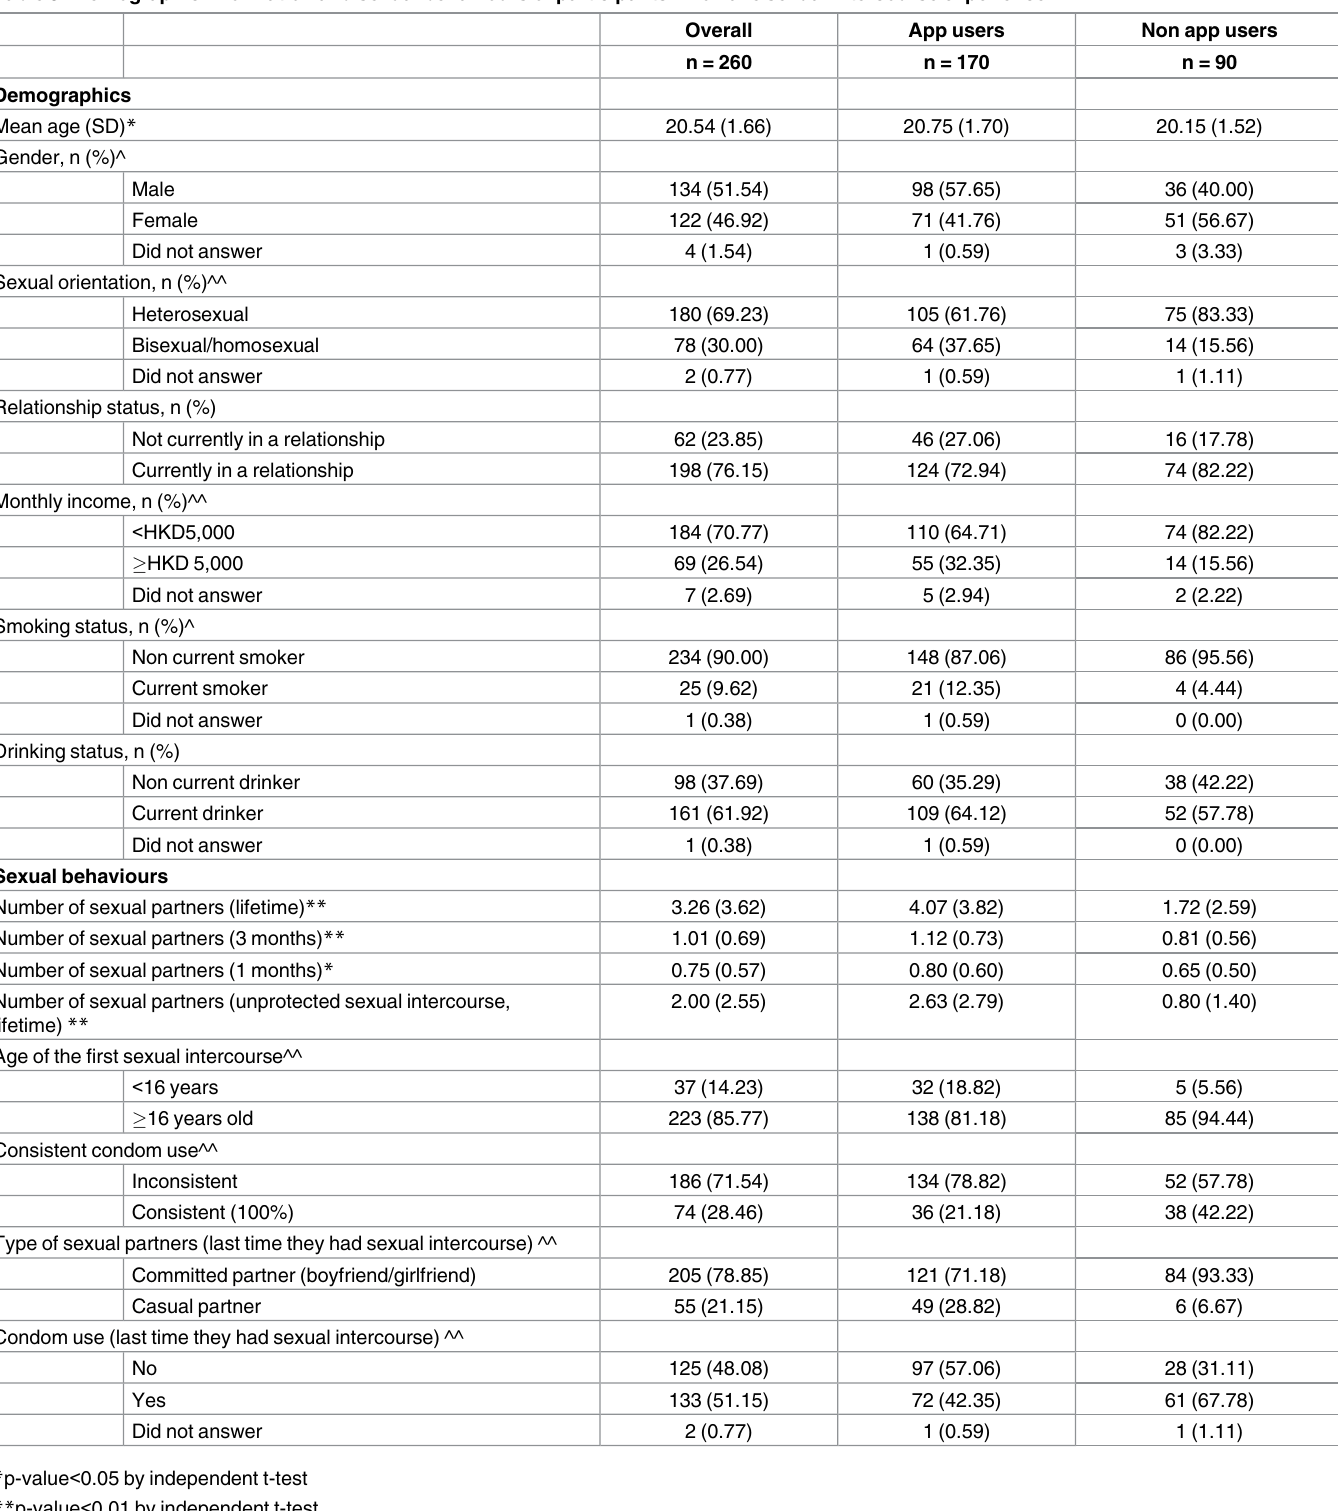
Table 3. Demographic information and sexual behaviours of participants who have sexual intercourse